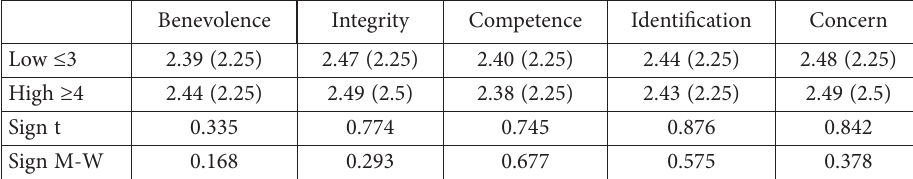
Table 6. Mean (median) trust dimensions scores: comparisons of social media activity (source: own